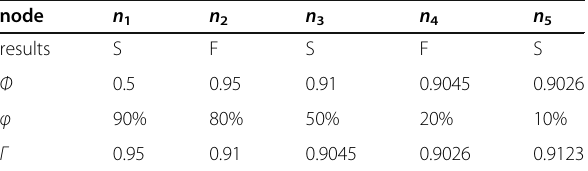
Table 7 Trust values of sink